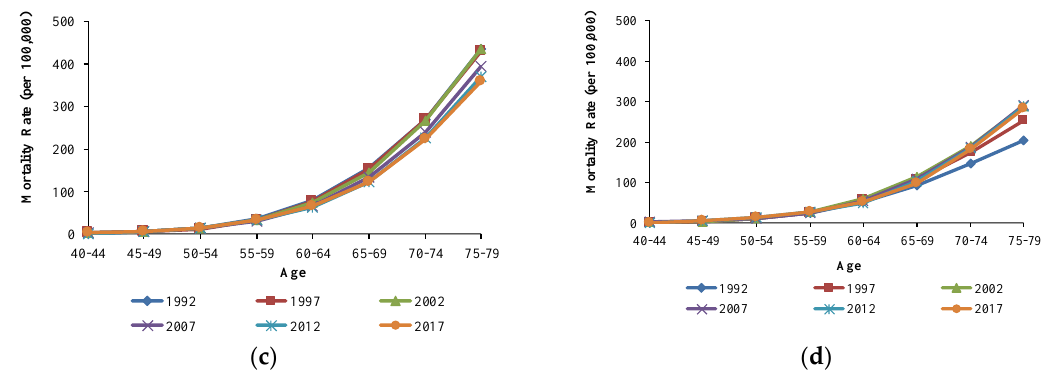
Figure 3. Age-specific COPD mortality rate for ( a ) Chinese males, ( b ) Chinese females, ( c ) U.S. males, and ( d ) U.S. females from 1992 to 2017.